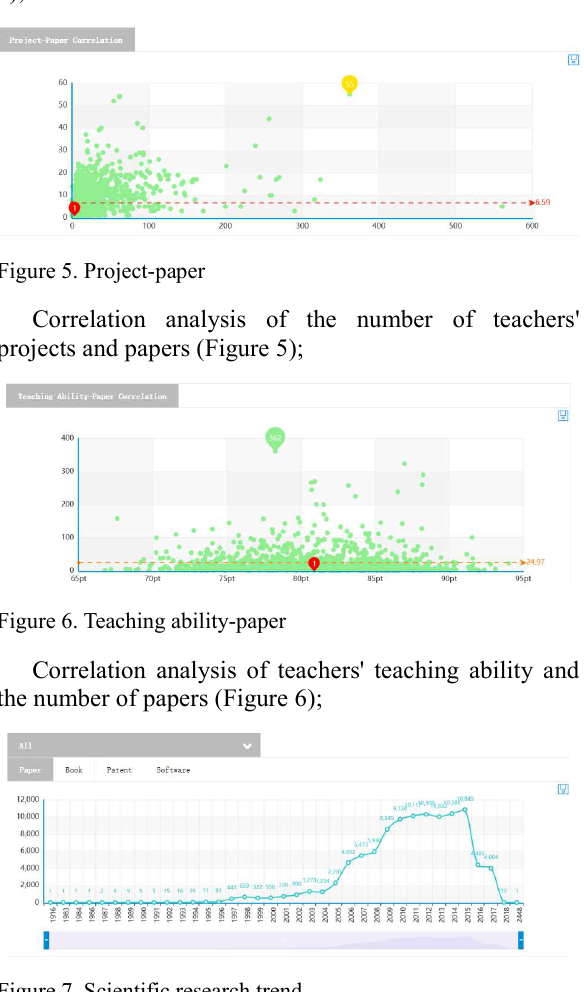
Figure 7. Scientific research trend